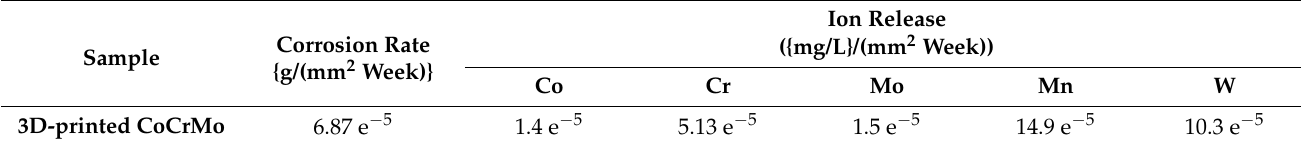
Table 4. Calculated corrosion and ion release rates.